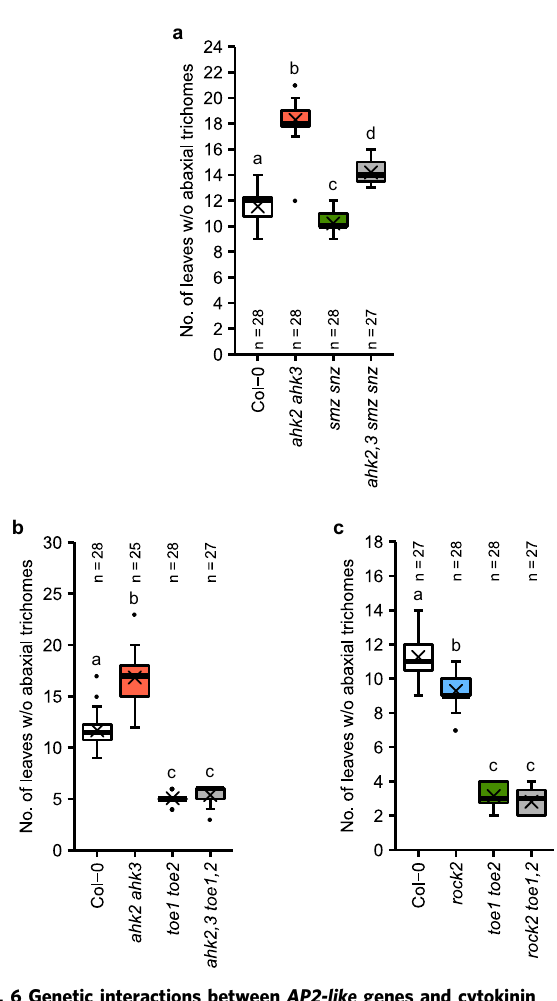
Fig. 6 Genetic interactions between AP2-like genes and cytokinin receptor genes regarding vegetative phase change. Number of leaves without abaxial trichomes in ahk2,3 smz snz ( a ), ahk2,3 toe1,2 ( b ) and rock2 toe1,2 ( c ) hybrid plants grown in SD. In box plots, the center line represents the median value and the boundaries indicate the 25th percentile (upper) and the 75th percentile (lower). The X marks the mean value. Whiskers extend to the largest and smallest value, excluding outliers which are shown as dots. Letters indicate signi fi cant differences between the genotypes, as calculated by Kruskal – Wallis test ( q < 0.05). Exact q -values are included in the Source Data fi les.